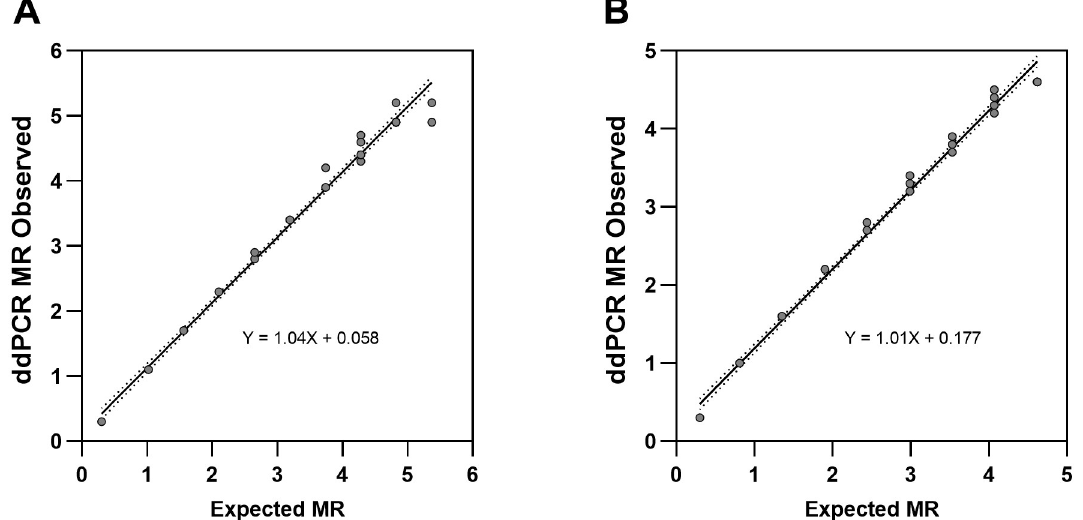
Fig 3. Linearity by breakpoint. A. The e13a2 transcript was diluted from MR0.3-MR4.7 with 4 replicates at each concentration shown as grey circles. The solid black line is the linear regression and has a y intercept equal to 0.1218, slope of 1.004 and a R 2 of 0.99. B. The e14a2 transcript was diluted from MR0.3-MR4.7 with 4 replicates at each concentration shown as grey circles. The solid black line is the linear regression and has a y intercept equal to 0.1730, slope of 1.015 and a R 2 of